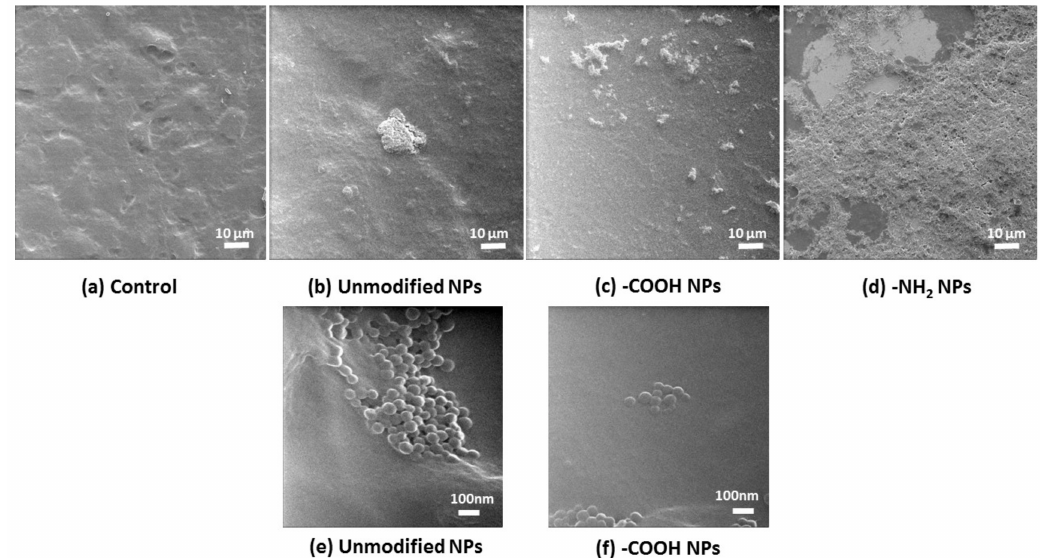
Figure 6. Effect of polystyrene nanoparticles on Caco-2 visualized by helium ion microscopy. Caco-2 cells in the abscense ( a ) and presence of ( b ) unmodified; ( c ) -COOH functionalized and ( d ) -NH 2 functionalized NPs visualized by HIM showing the cytotoxic effect of the positively charge NPs. The lowest micrographs show the interaction of the ( e ) unmodified and ( f ) -COOH NPs with the cells at higher magnification and confirm the integrity of the cells.